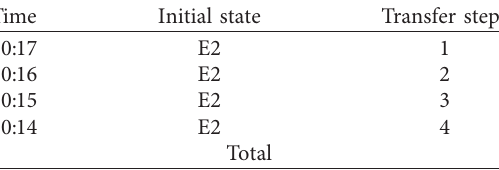
Table 5: 10:19 Prediction of mine dust concentration.